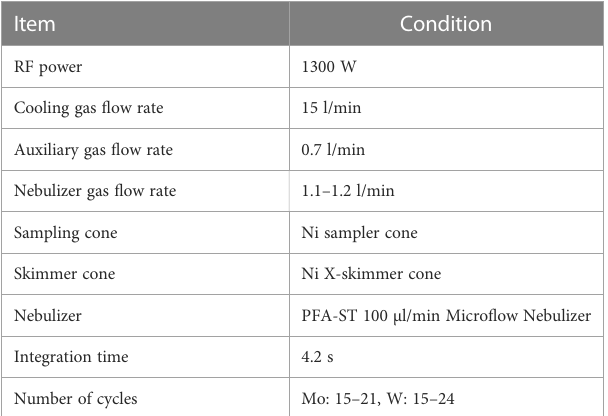
TABLE 3 Major conditions of MC-ICP-MS measurement.